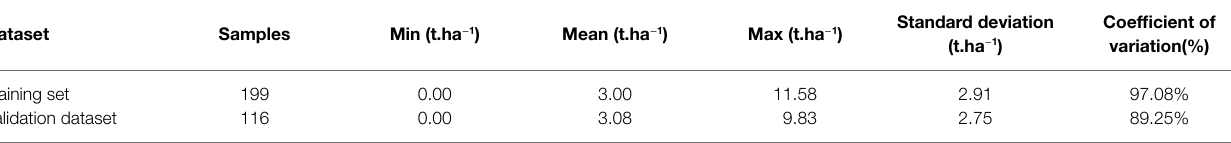
TABLE 2 | Cotton yield descriptive statistics.